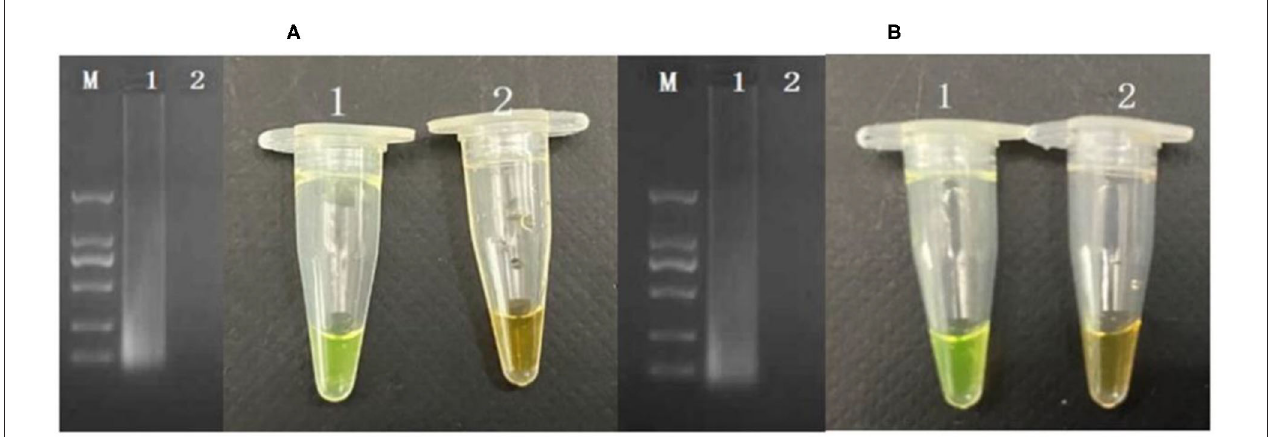
FIGURE 4 | Application of detection of VBNC cells in pure cultures (A) and food samples (B) . M-DNA marker; 1: VBNC cells in pure culture; 2: dead cells in pure culture.